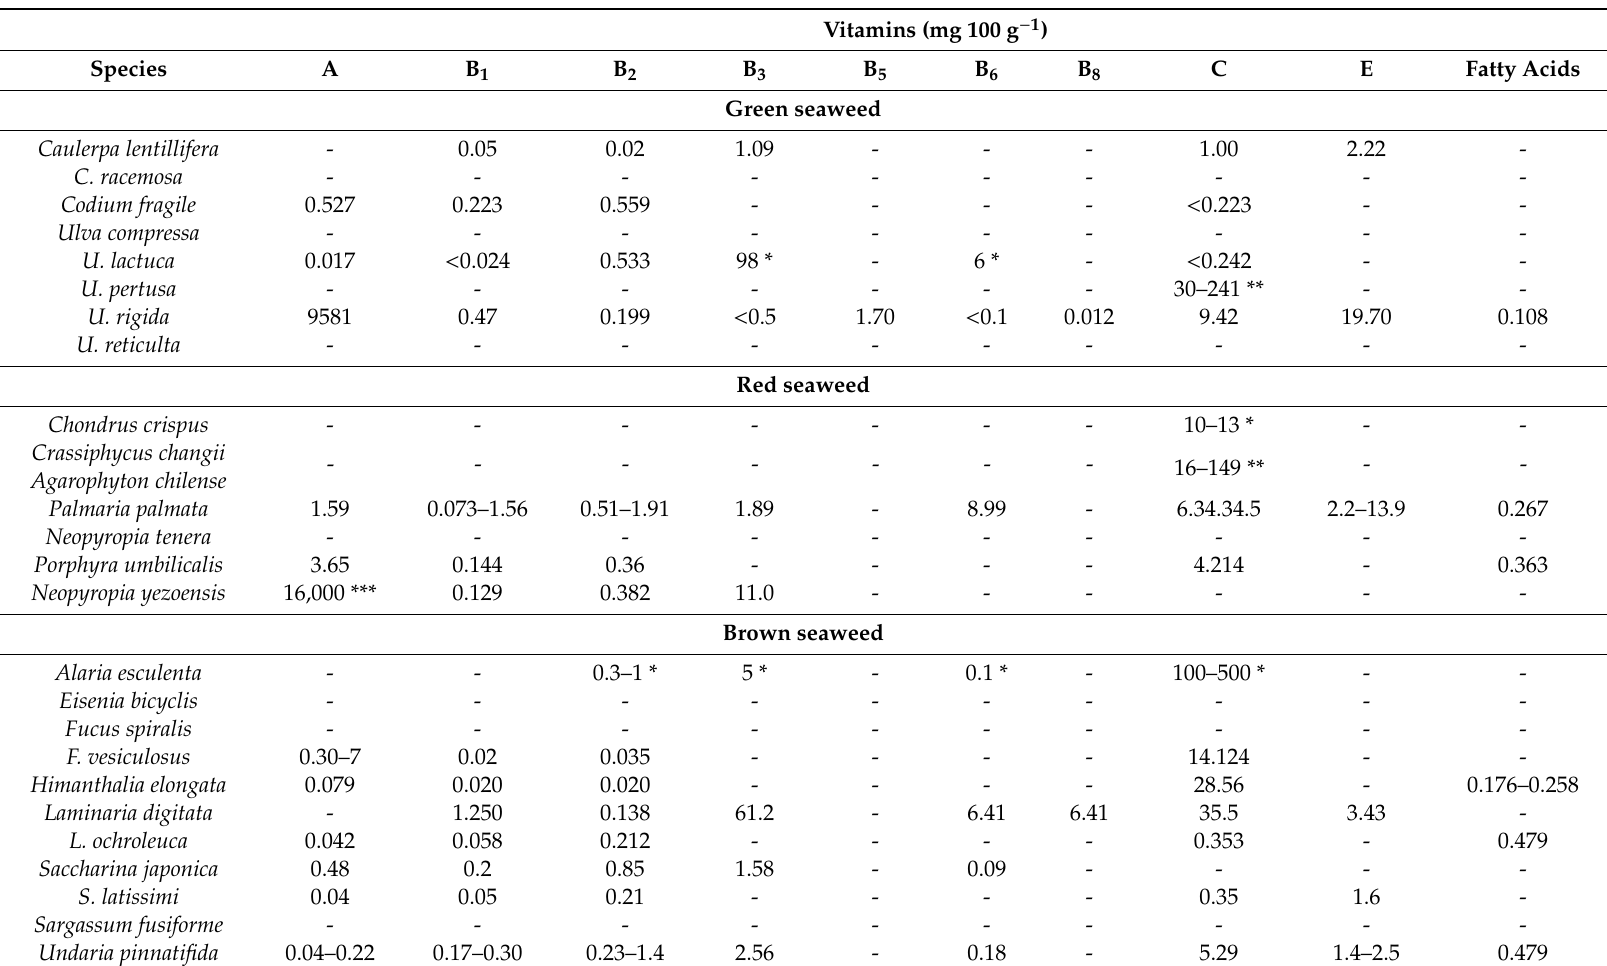
Table 2. Vitamins contents (mg 100 g − 1 edible portion) of seaweeds